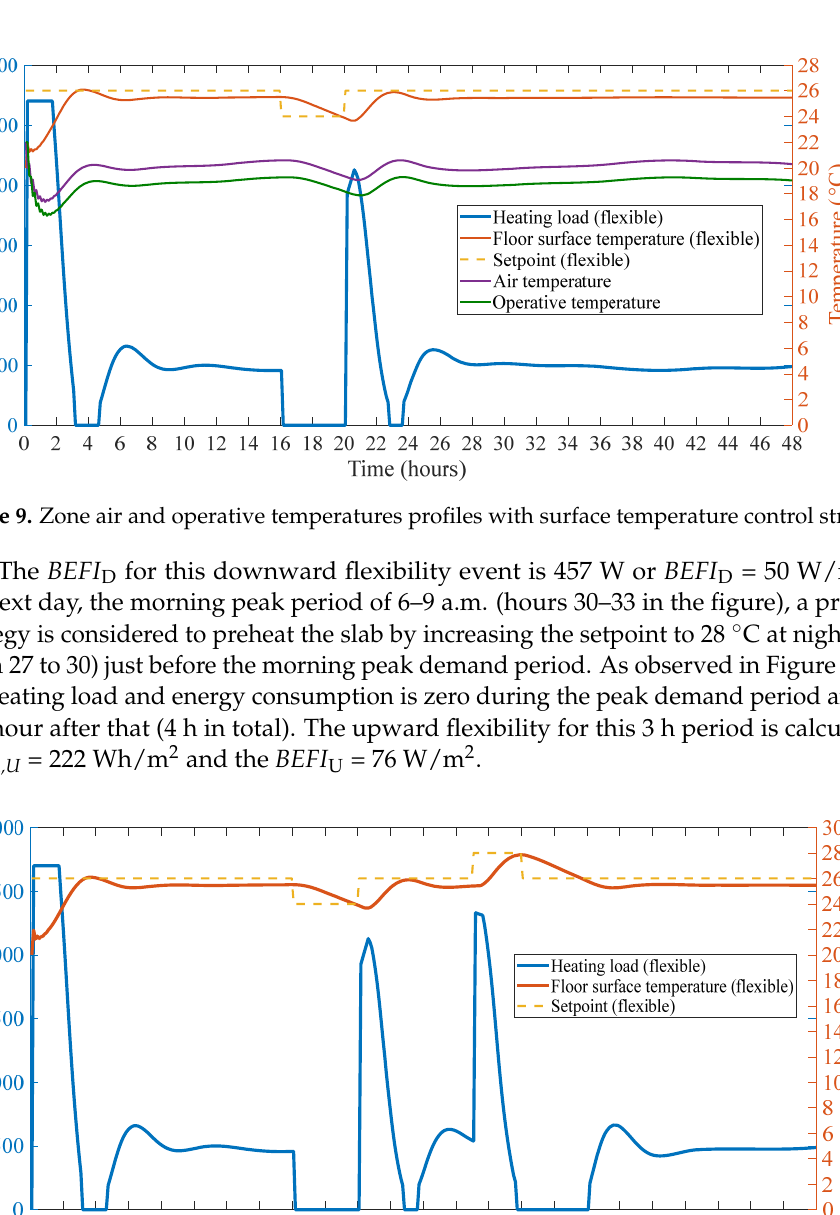
Figure 10. Upward flexible case for floor surface temperature control.